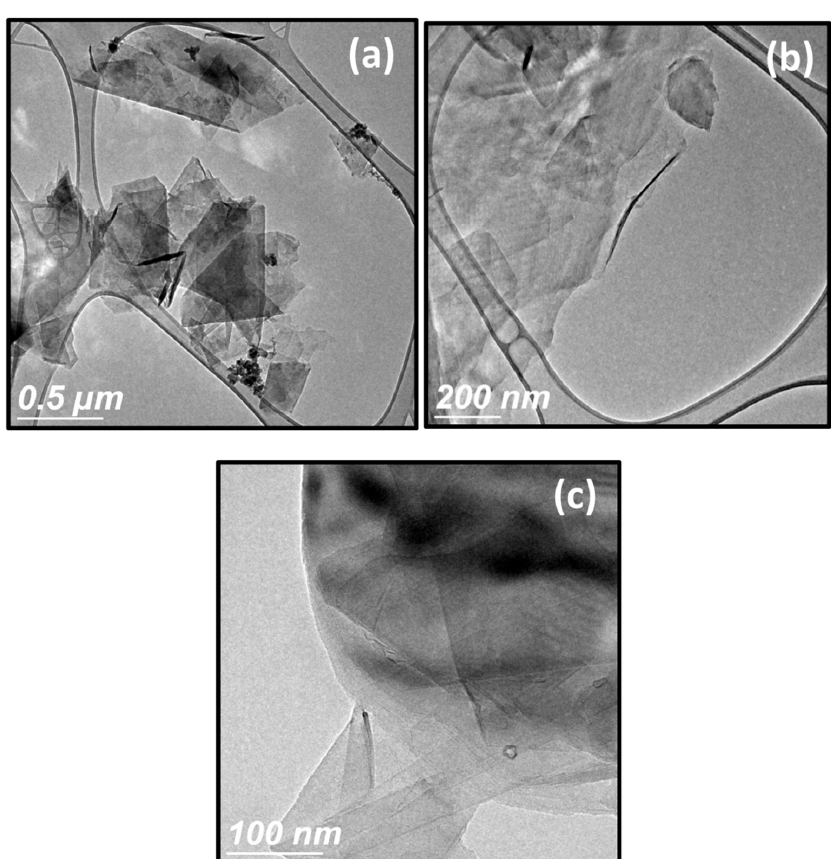
Figure 2. TEM images of graphene sheets in solution obtained by sonication: ( a ) multilayer, ( b ) several sheets and ( c ) an individual few-layered sheet.